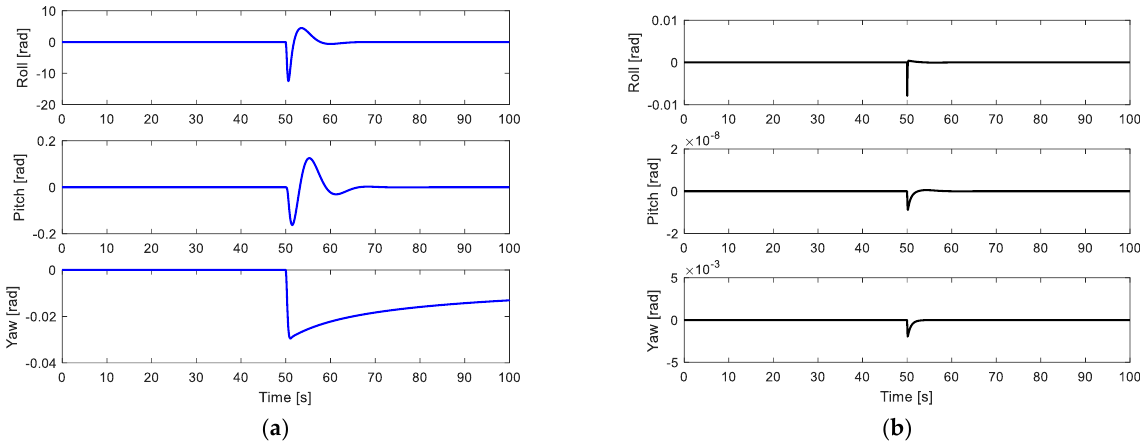
Figure 3. Attitude angle performance with 50% LoCE in actuator #2: ( a ) ASMC; ( b ) Proposed FTC.